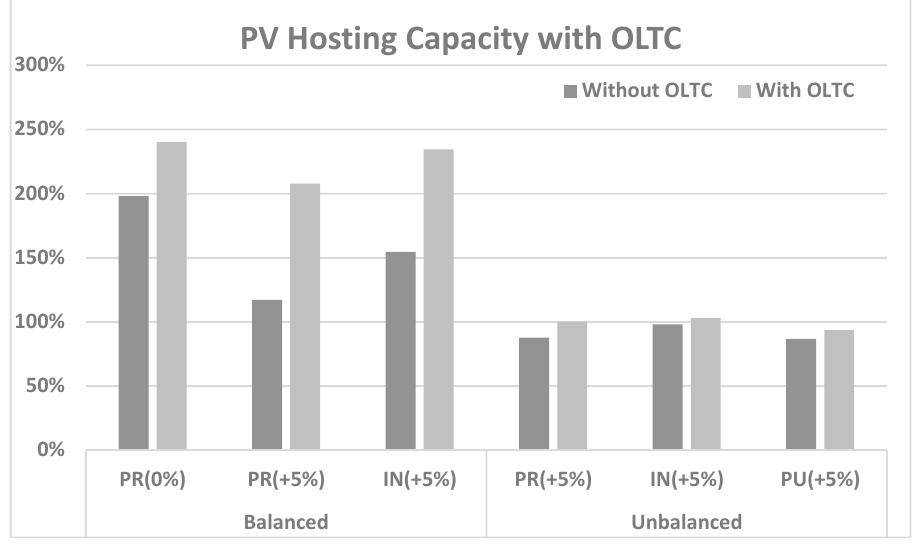
Figure 6 . PV hosting capacity, with and without, OLTC inclusion. Figure 6. PV hosting capacity, with and without, OLTC